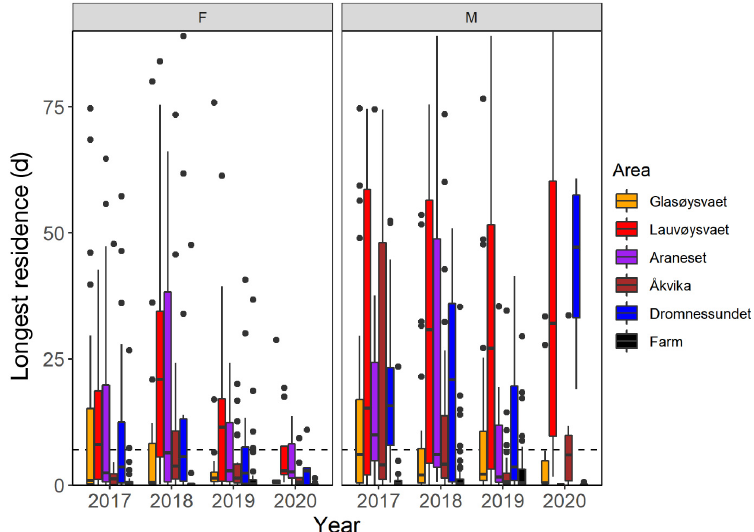
Fig. 5. Longest residence times of individual cod during the putative spawning period at each of the different spawning grounds and at the farms during the study years. Dotted line indicates a residence of 7